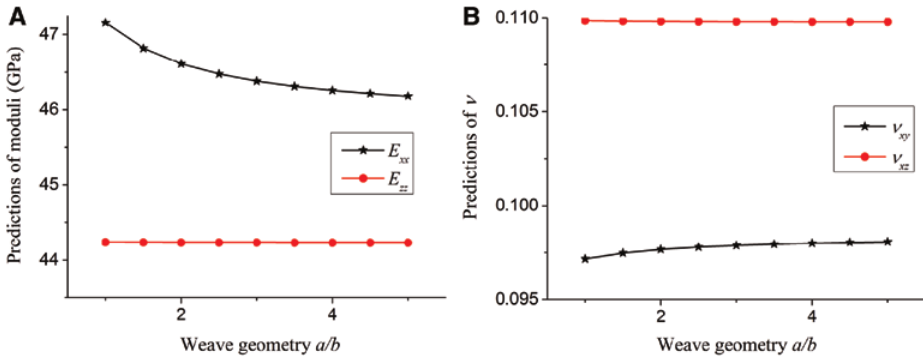
on predicted values. x